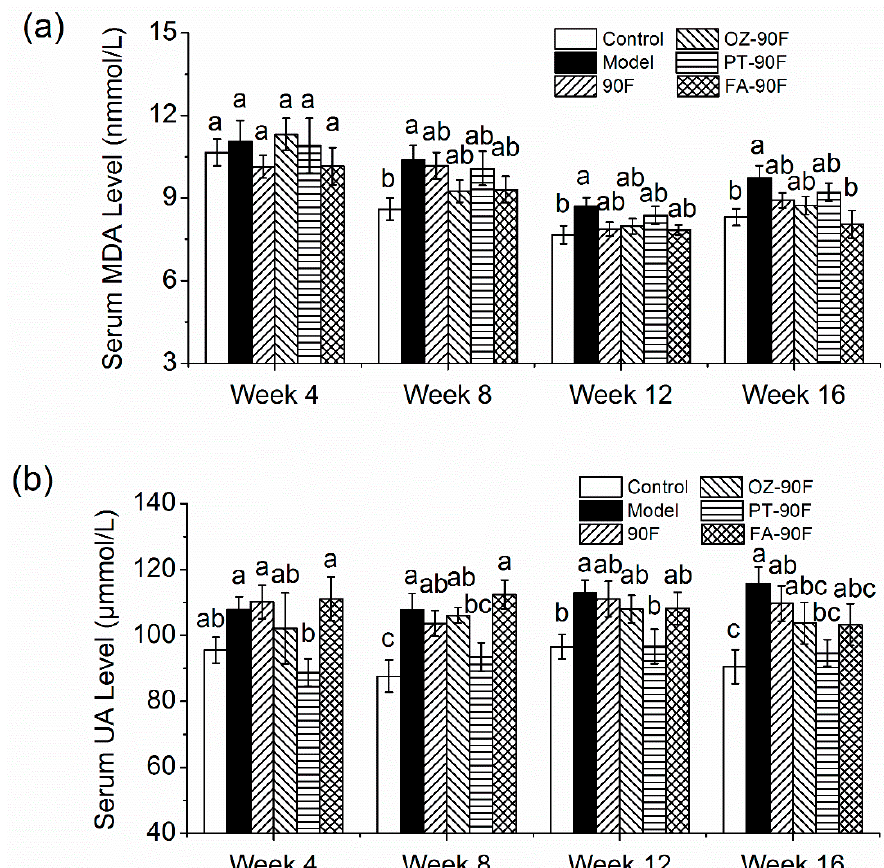
Figure 6. E ff ect of enriched flour on oxidative stress and hyperuricemia in rats. The same serum was used as Figure 3 for measurement of MDA ( a ) and UA ( b ) levels. Mean values with di ff erent letters from the same week are significantly di ff erent ( p < 0.05). 90F, 90% wheat flour; OZ-90F, γ -oryzanol enriched 90% wheat flour; PT-90F, phytosterol enriched 90% wheat flour; FA-90F, ferulic acid enriched 90% wheat flour.